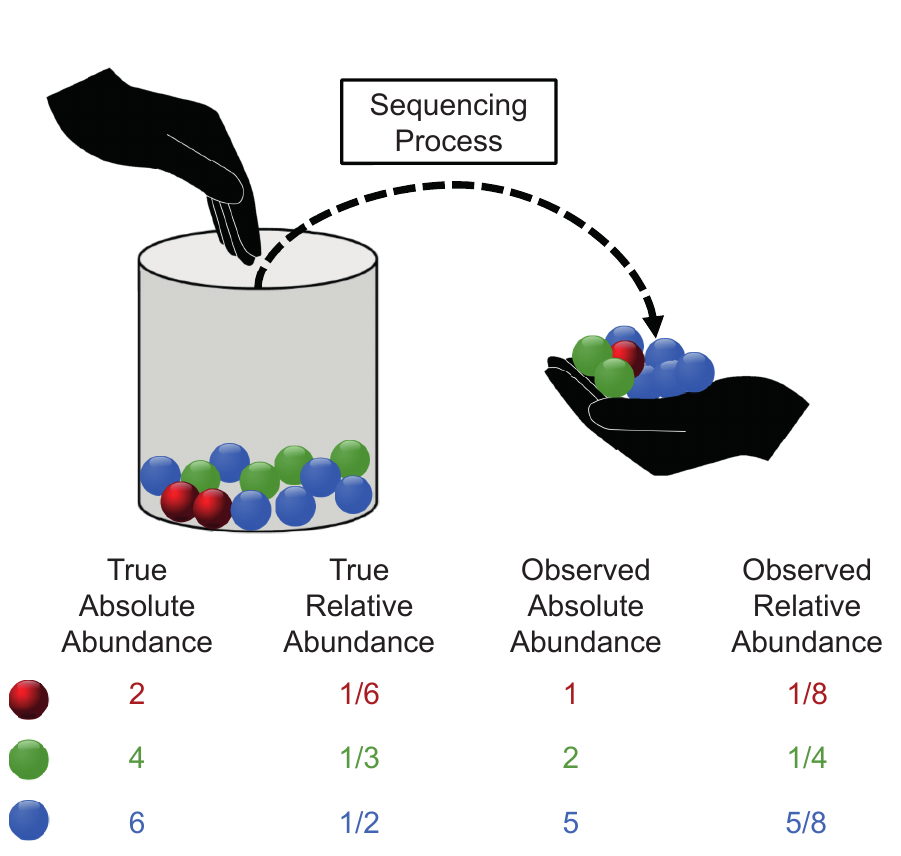
Fig 1. Summary of notations. The urn represents the real microbial population where different bacteria are represented by spheres of different colours. The sequencing process can be described by sampling without replacement with a limited number of extractions (i.e. the sequencing